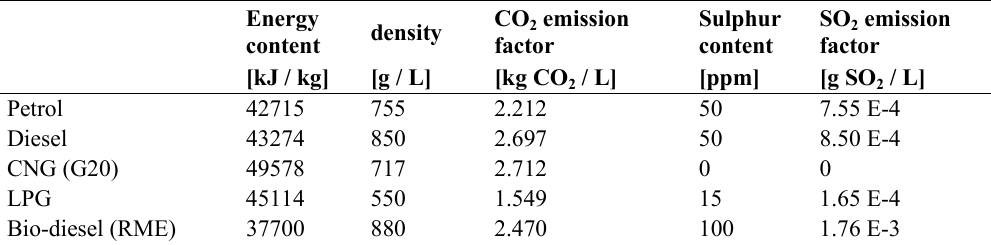
Table 1. Fuel characteristics used in the Ecoscore